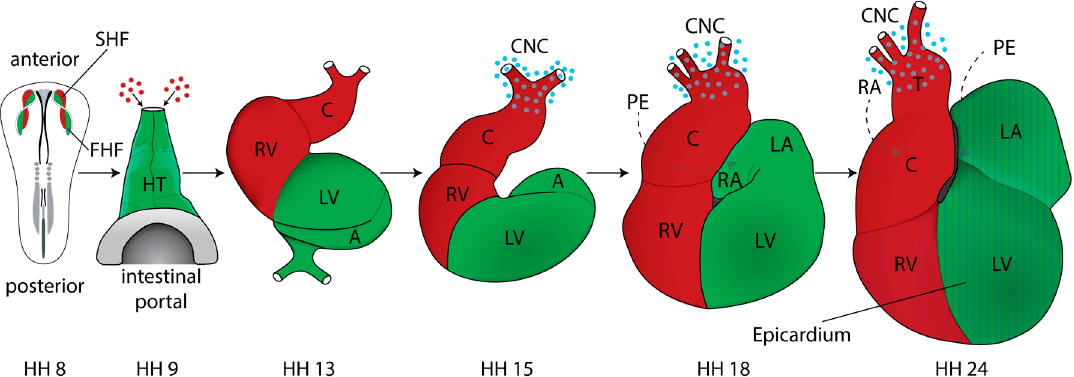
Figure 2. Cardiac morphogenesis in chick embryos. Schematic ventral views of HH8 to HH24 chick hearts. Fate mapping revealed the location of first and second heart fields (FHF, SHF), marked in green and red. Fusion generates a primitive heart tube by HH9; secondarily added cell populations have not yet entered (red dots). In all images, components of the heart derived predominantly from FHF are in green and components derived predominantly from SHF and also AHF are in red. During dextral-looping the straight heart tube transforms into a C-shaped bend by HH13 and SHF/AHF-derived cells contribute to the heart; primitive atria move dorsocranially. Further positional changes are indicated. The proepicardium (PE) is located on the dorsal side (stippled grey arrow); it generates the epicardium. The expansion of the epicardium over the heart by HH24 is indicated by stripes. The cardiac neural crest (CNC), shown as blue spots, contributes to outflow tract septation and remodeling of the great arteries. See text for details. A, atrium; C, conus, CNC, cardiac neural crest; HT heart tube; LA/RA, left/right atrium; LV/RV, left/right ventricle; T, truncus arteriosus